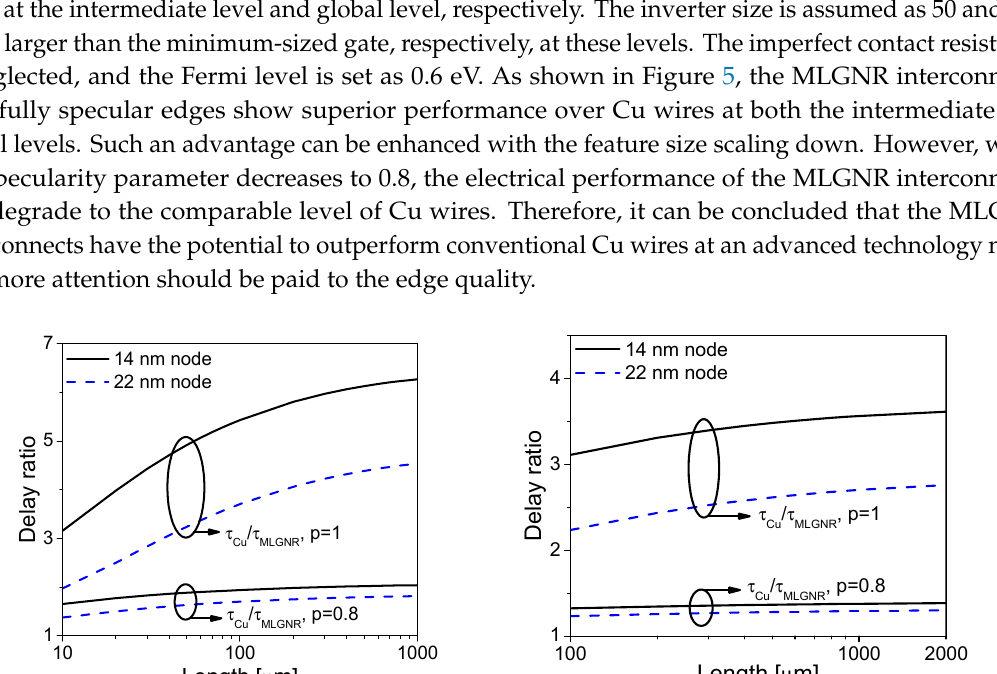
Figure 5. Time delay ratios of MLGNR interconnects and Cu wires at the ( a ) intermediate level and ( b ) global level [28].